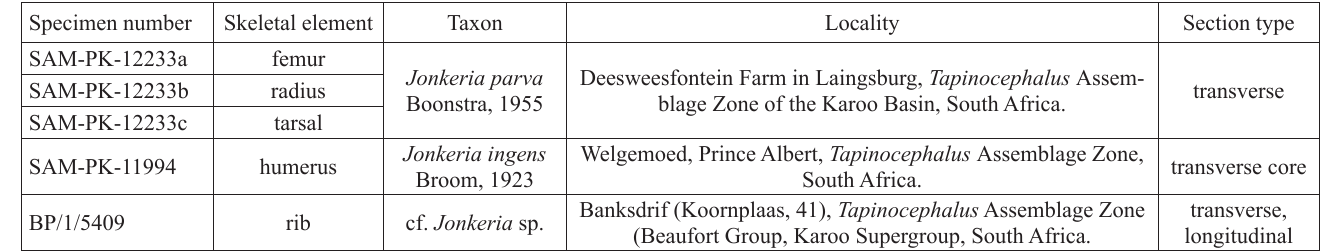
Table 1. Skeletal elements of Jonkeria that were studied. All the material was recovered from the Tapinocephalus Assemblage Zone (Beaufort Group, Karoo Supergroup), South Africa. Source of information: Boonstra (1955, 1969); King (1988). SAM-PK-12233a/b/c are different elements of the same